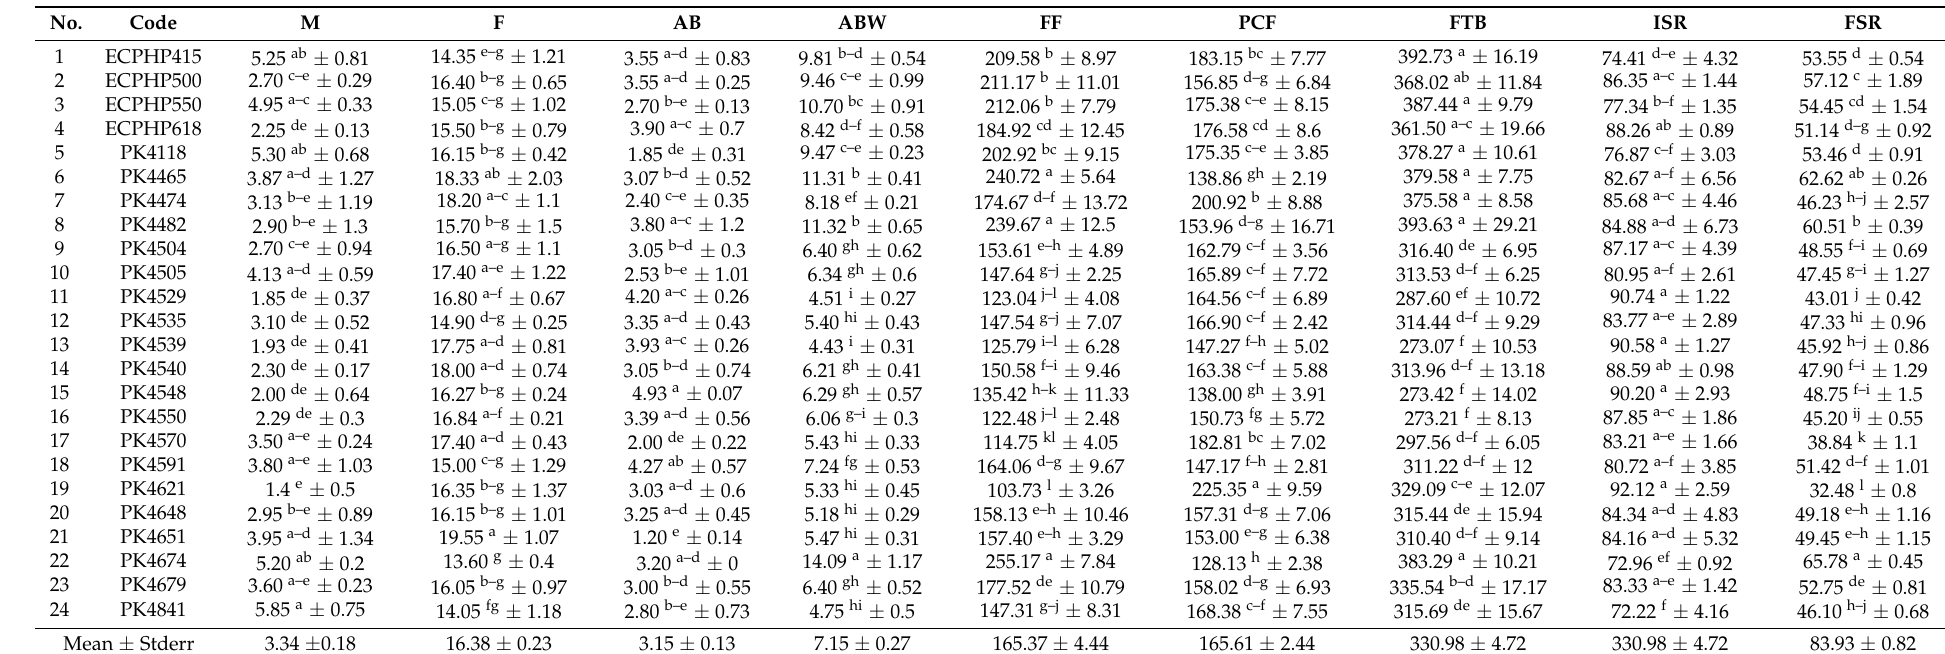
Table 3. Mean comparison and standard error ( ± ) of D × P biparental progenies for fruit set and other yield